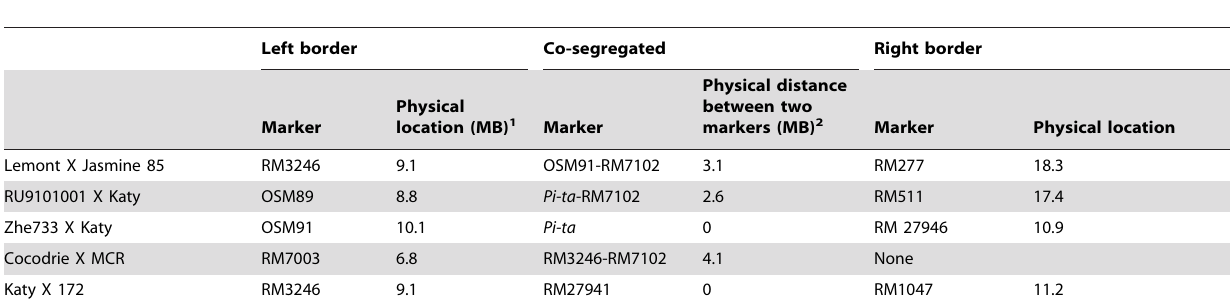
Table 1. Physical distances of SSR markers co-segregated with Pi-ta and with both borders of the recombination break points in mapping populations.